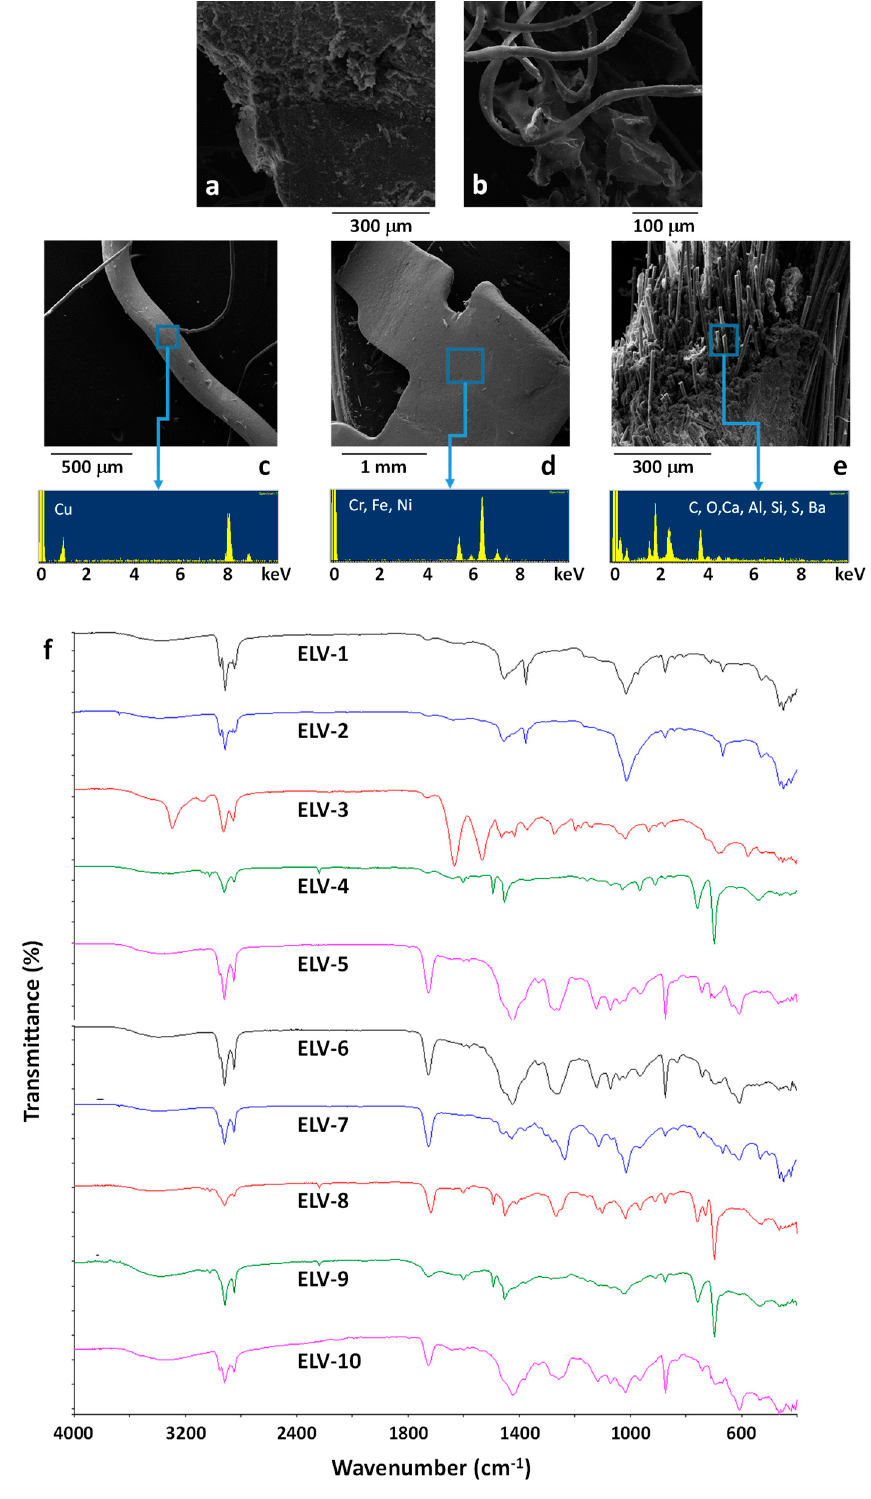
Figure 6. SEM images ( a,b ) and SEM / EDX results ( c,d,e ) of untreated ELV samples. ATR-FTIR of randomly selected ELV particles ( f